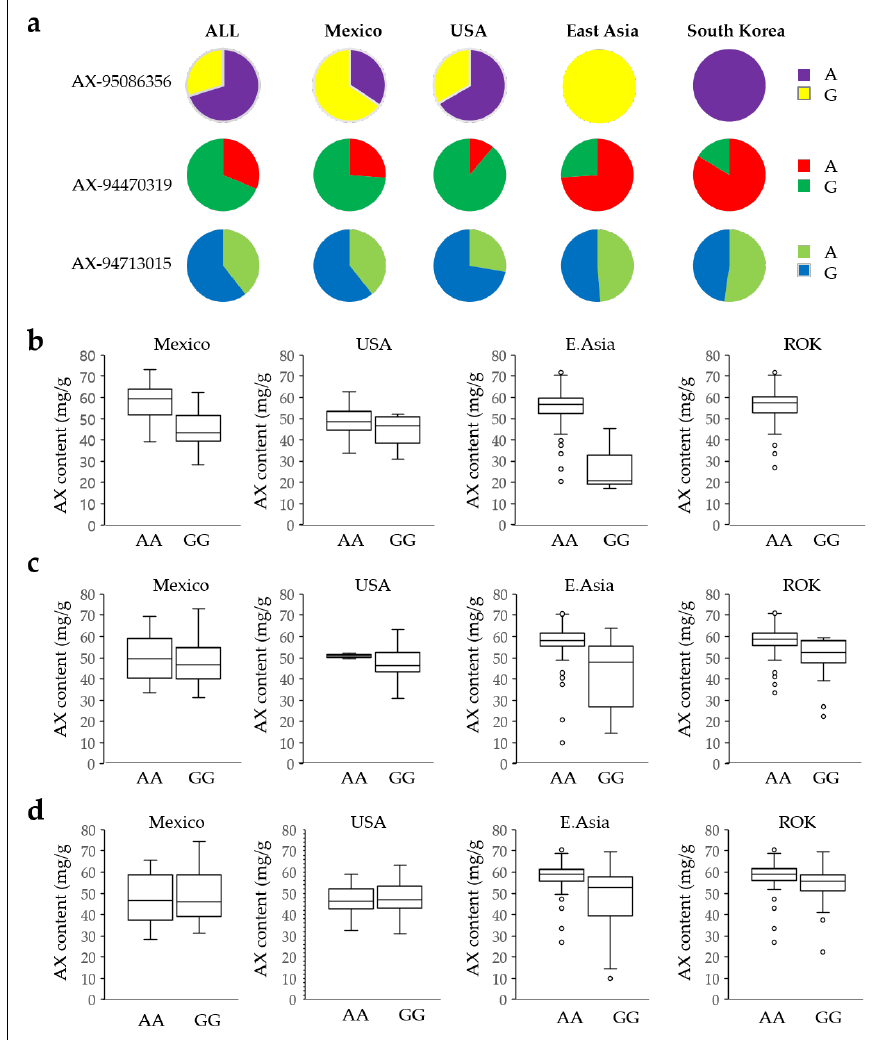
Figure 6. Arabinoxylan level by country according to the three SNP alleles. ( a ) Adenine and guanine rates by country; ( b ) AX level by country according to the SNP allele in AX-95086356; ( c ) AX-94470319; and ( d ) AX-94713015. The X-axis depicts the two alleles, and the Y-axis represents the AX content. AX, arabinoxylan; A, adenine; G, guanine. ROK, Republic of Korea.